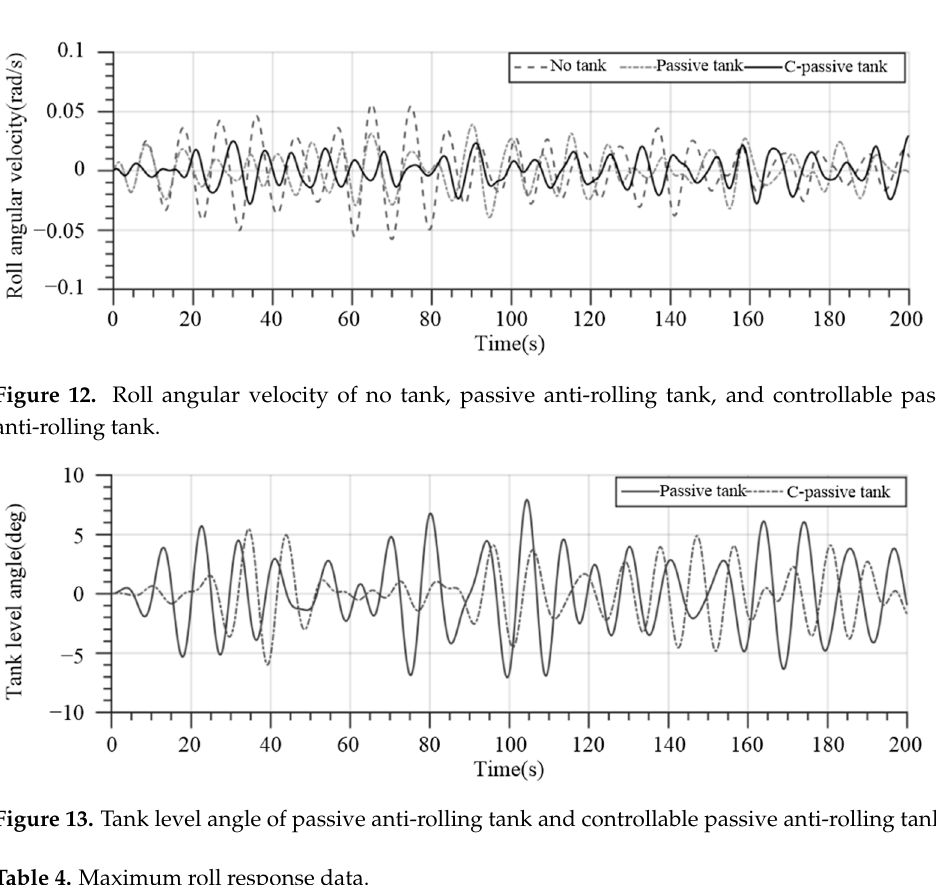
Figure 11. Roll angle of no tank, passive anti-rolling tank, and controllable passive anti-rolling tank.